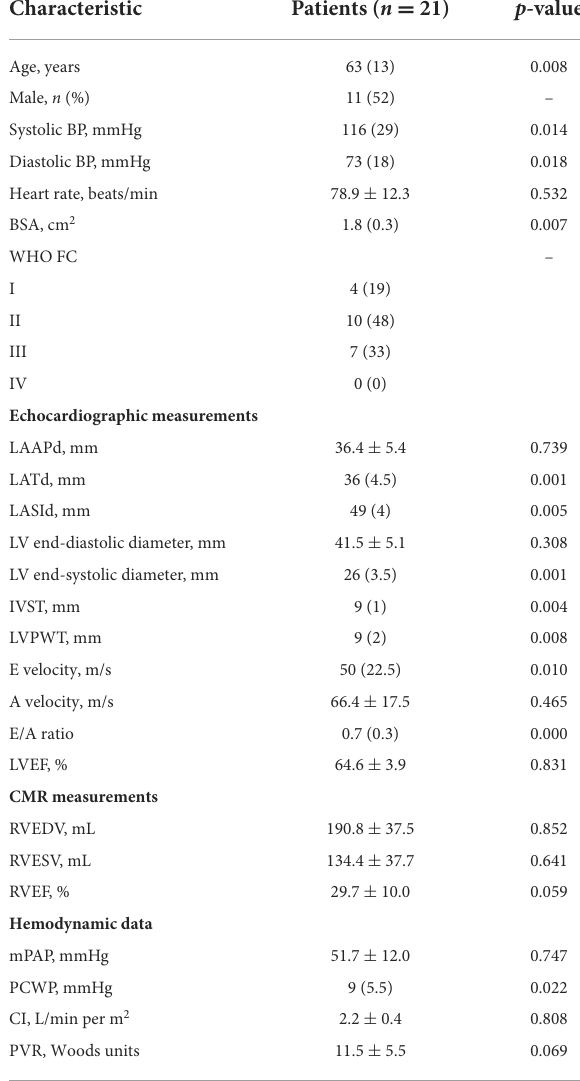
TABLE 1 Demographic, clinical, and hemodynamic characteristics at